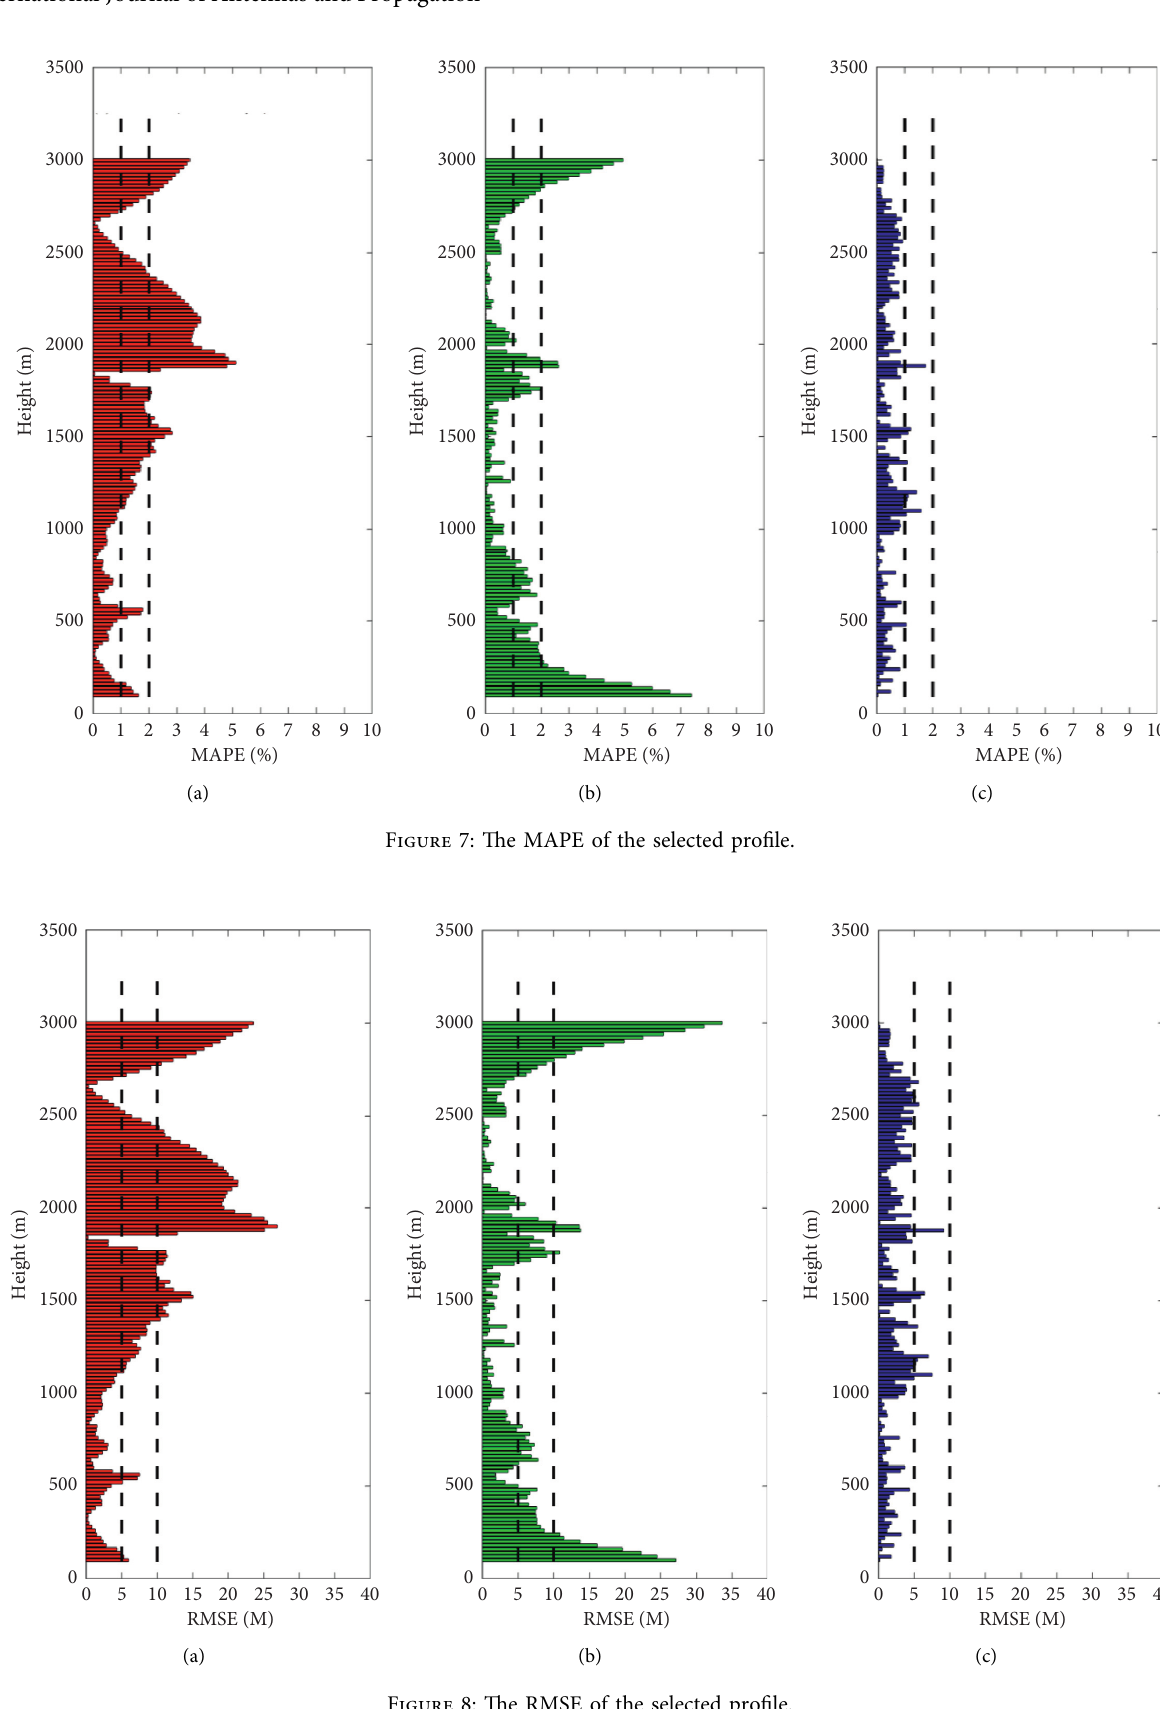
Figure 8: The RMSE of the selected profile.